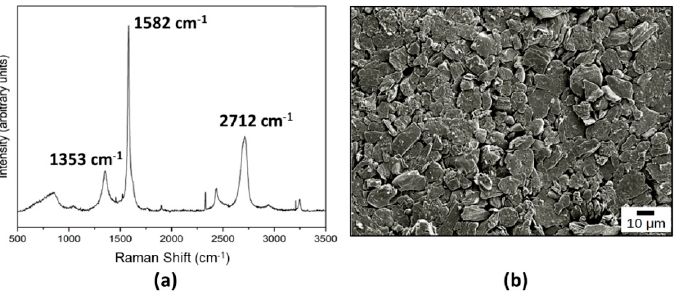
Figure 2. ( a ) Raman spectrum of a virgin NG layer in the fabricated NG/Cu anode; ( b ) SEM image of the surface of the NG layer characterized by the Raman analysis shown in ( a ).